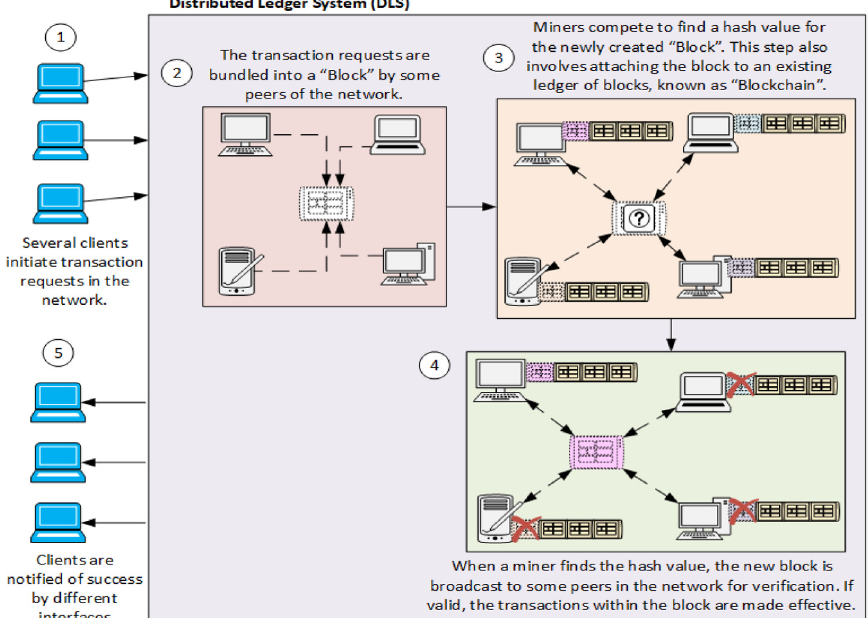
Figure 1. Simpli fi ed